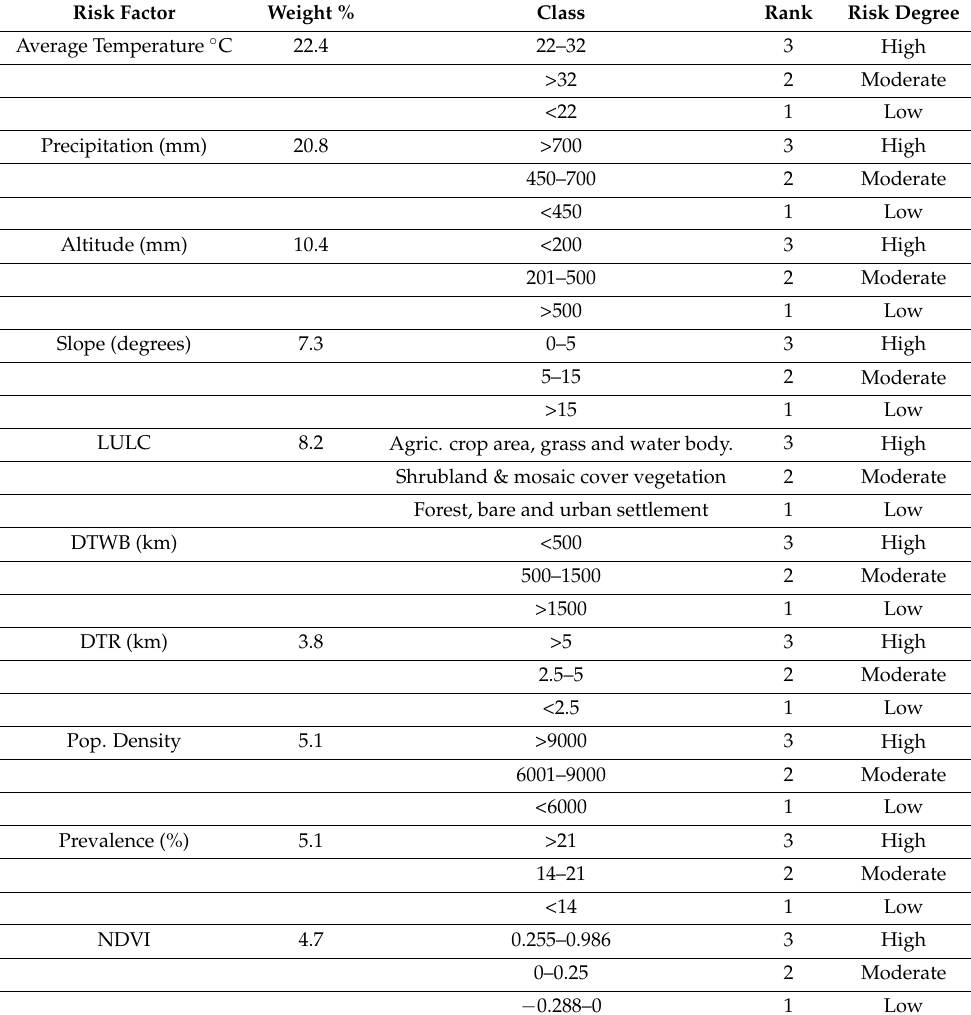
Table 1. Malaria risk factor, weights, and classes of anthropic and environmental